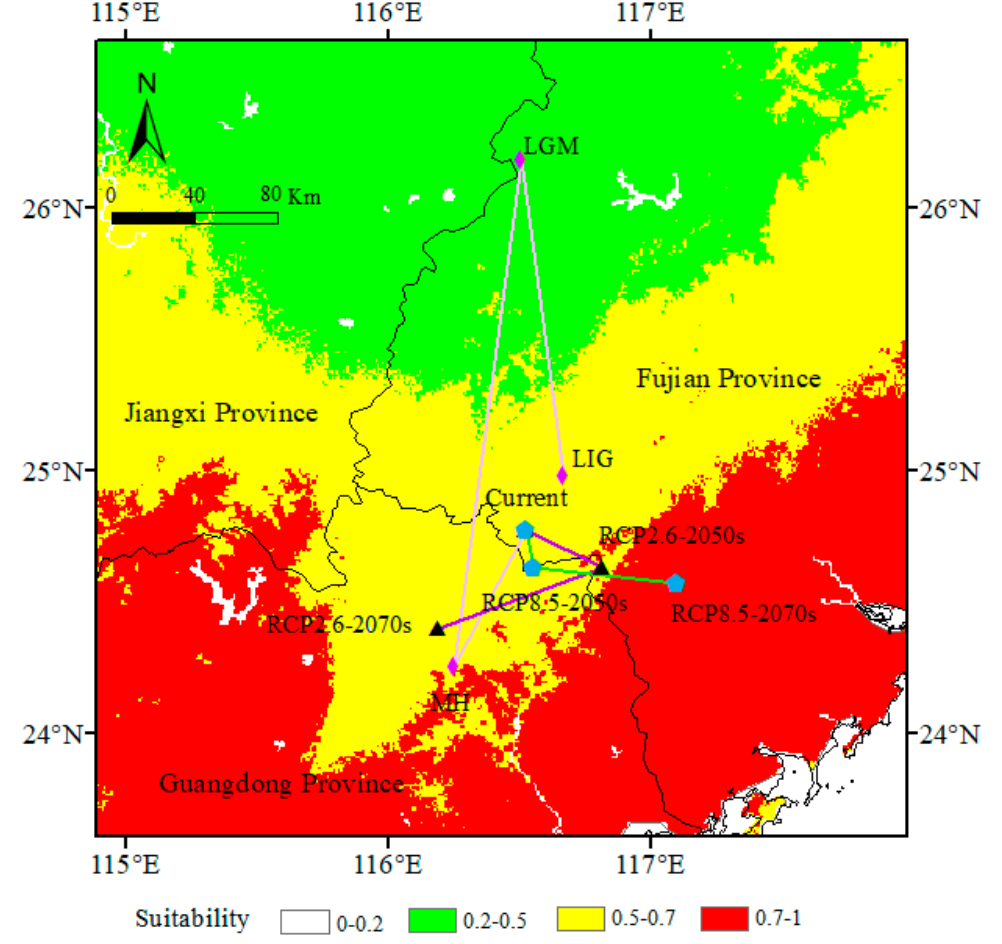
Figure 6. Migration location of the center of suitable habitats of G. pensilis under different climate change